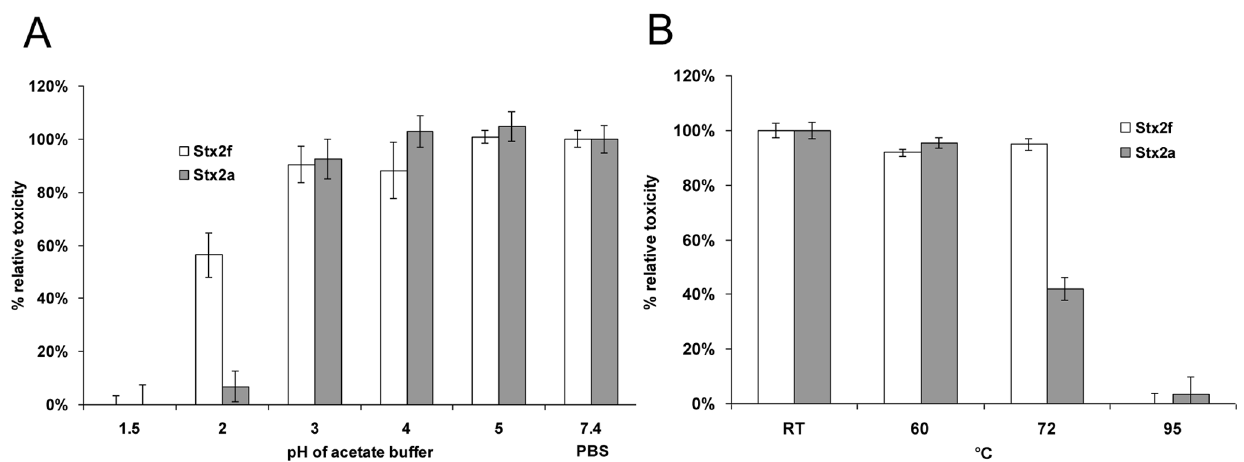
Figure 4. Stability of the Stx2f subtype. A. Toxicity of Stx2f and Stx2a after a one hour incubation under the indicated low pH conditions. Toxins were applied at a 5 ng/mL concentration. A representative experiment is shown (N=5). B. Toxicity of Stx2f and Stx2a after a one hour incubation at the indicated elevated temperatures. Toxins were applied at a 5 ng/mL concentration. A representative experiment is shown (N=3).